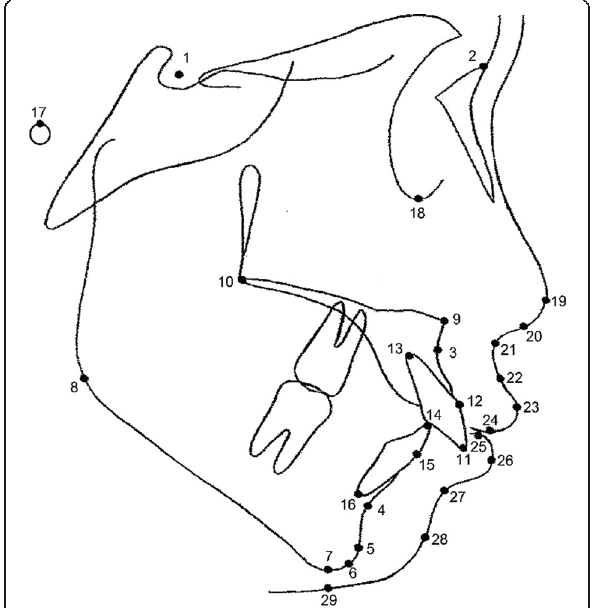
Fig. 1 Cephalometric landmarks. 1 S (sella turcica), 2 N (nasion), 3 A (subspinale), 4 B (supramentale), 5 Pg (pogonion), 6 Gn (gnathion), 7 Me (menton), 8 Go (gonion), 9 ANS (anterior nasal spine), 10 PNS (posterior nasal spine), 11 maxillary central incisor edge, 12 the most anterior labial point of maxillary central incisor, 13 maxillary central incisor apex, 14 mandibular central incisor edge, 15 the most anterior labial point of mandibular central incisor, 16 mandibular central incisor apex, 17 Po (porion), 18 Or (orbitale), 19 Pr (pronasale), 20 Cm (columella), 21 Sn (subnasale), 22 Sls (superior labial sulcus), 23 Ls (labrale superius), 24 Ss (stomion superius), 25 Si